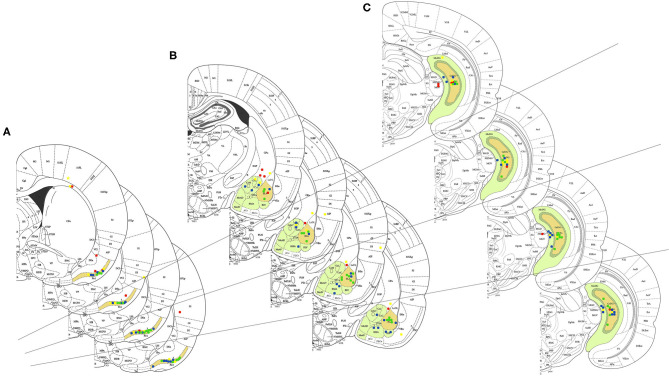
General electrode positioning data in the groups: No Stimulus and Water (1st plate or superior plate), Stimulus and Water (2nd plate), No Stimulus and TMT (3rd plate), and Stimulus and TMT (4th plate or inferior plate), with schematic design in the following areas: (A) piriform cortex, (B) amygdaloid complex, and (C) hippocampal formation, all in the left hemisphere of the 57 animals that were implanted with electrodes in the stereotaxic surgery. The following are represented in closed circles with different colors: red, the animals that hit only one of the cerebral areas described above; yellow, the animals with accuracy in two brain areas (piriform cortex, amygdaloid complex, and/or hippocampal formation); blue, the animals with electrode positioned in the piriform cortex, amygdaloid complex, and hippocampal formation; and green, the animals with the positioning in the piriform cortex, basolateral amygdala, and hilus of the gyrus dentate.